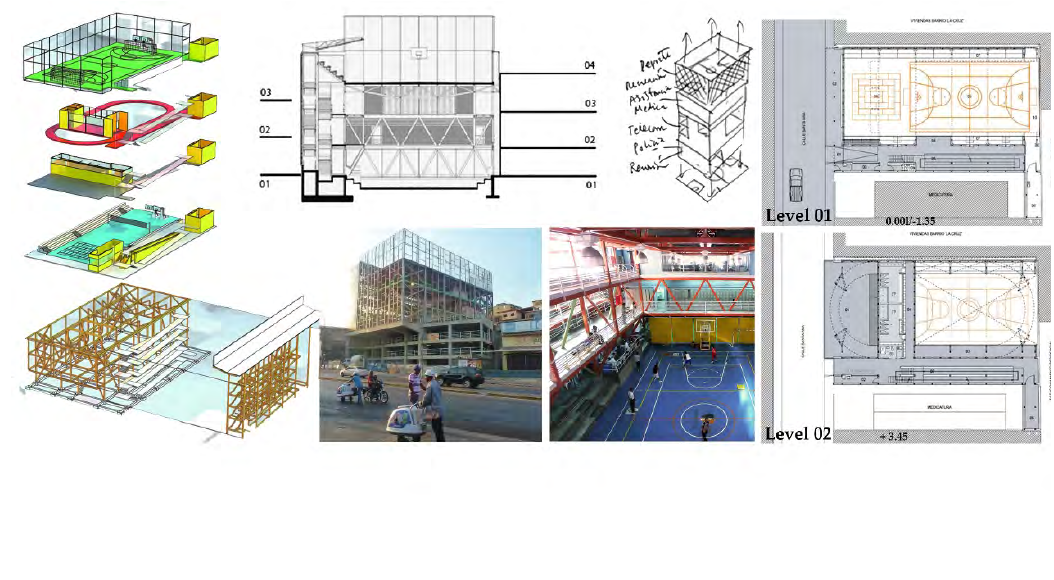
Figure 7. The vertical gym drawings showed how the project is a replicable prototype and the project after implantation. Source U-TT. Brillembourg, A. & Klumpner, H.,